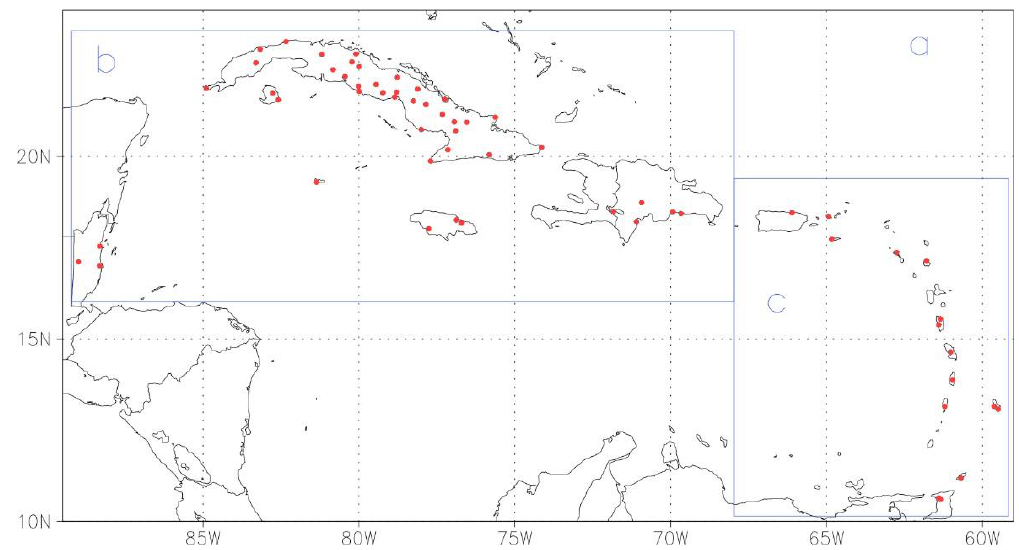
Figure 1. Study area and the location of the rain-gauge network. ( a ) Caribbean region, ( b ) the western Caribbean sub-region, and ( c ) the eastern Caribbean sub-region.